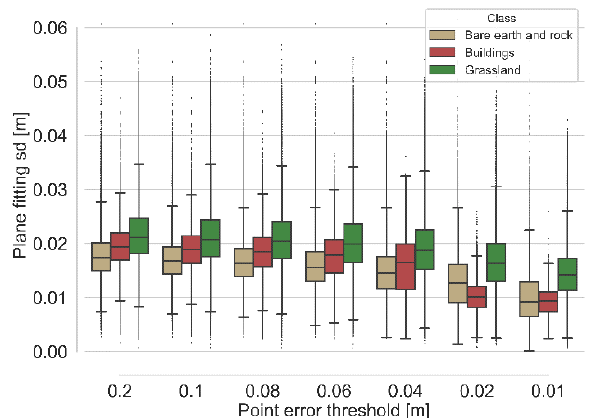
Figure 8. Plane fitting standard deviation for different surface classes with various point error thresholds ( t pe ) used for filtering the point